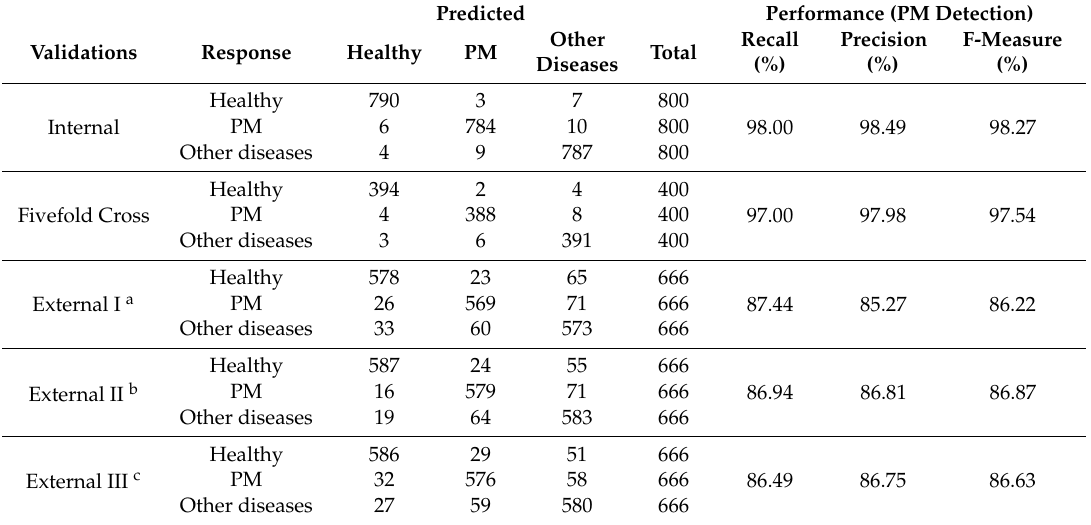
Table 5. Laboratory-based evaluation of artificial neural network (ANN) classifier for strawberry powdery mildew (PM) detection.